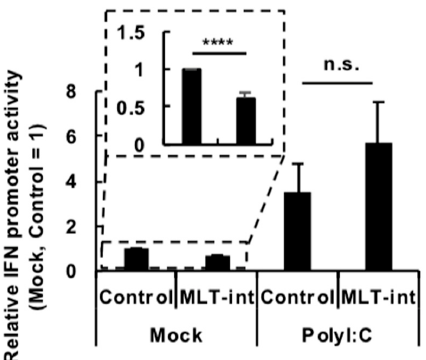
Figure 4. Suppression of interferon (IFN) promoter activity by MLT-int RNA in the absence of immune stimuli. The 293T cells were transfected with a plasmid expressing MLT-int RNA. After 24 h of incubation, the cells were treated with polyI:C and further incubated for 24 h. The values are expressed as the mean ± SE of at least four independent experiments; **** p < 0.001; n.s., no